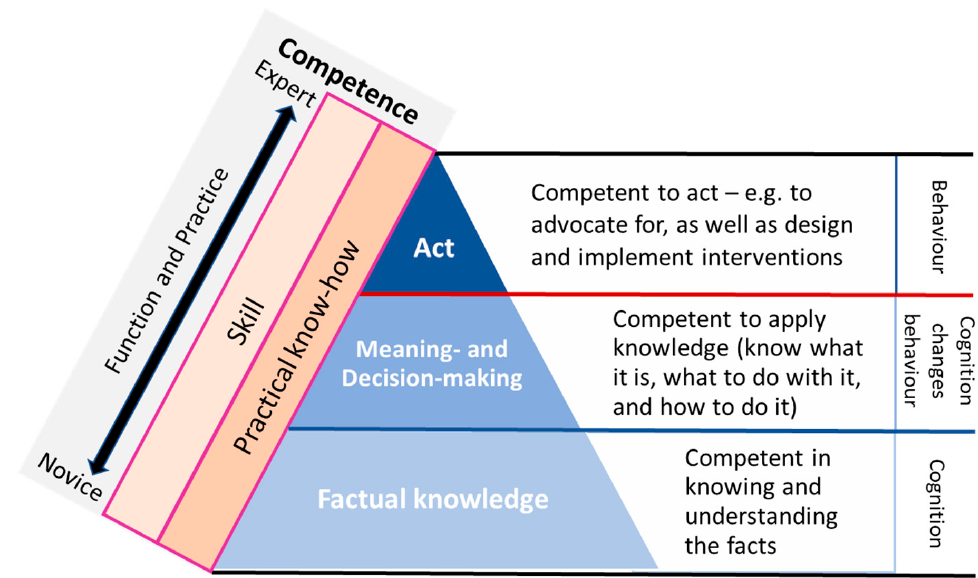
Figure 3. Framework for CECH Health Worker competence. This Health Worker Competency framework is developed from insights from [26–28].